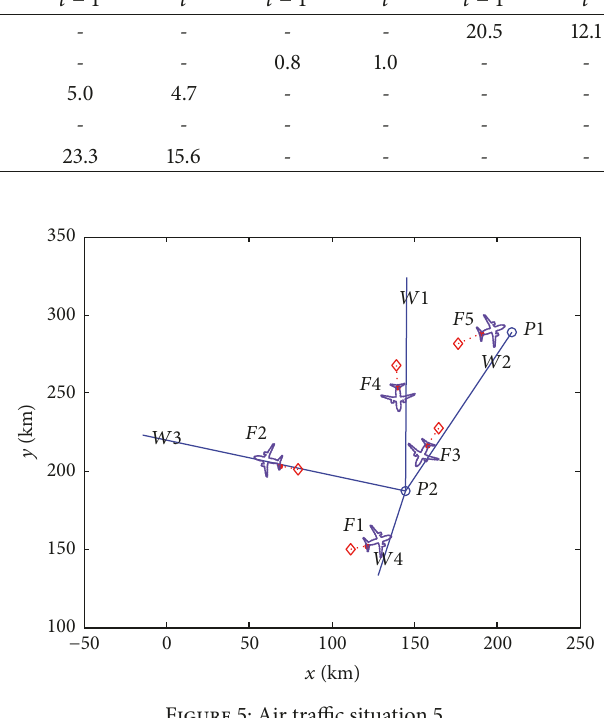
Figure 5: Air traffic situation